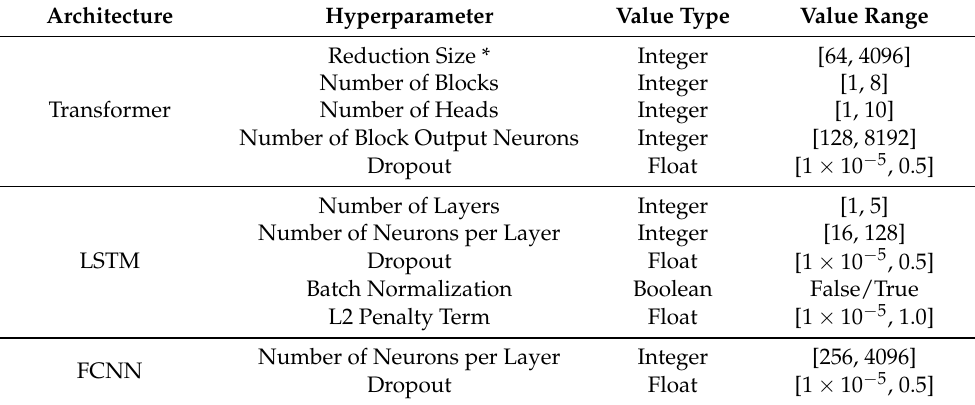
Table 2. Hyperparameter settings for the transformer, LSTM, and FCNN models. The table displays the architecture type in the first column, the hyperparameter name in the second column, the type of hyperparameter value in the third column, and the range of hyperparameter values in the fourth column. The FCNN model is represented as the regression component at the end of the transformer and LSTM models. (*) The reduction size hyperparameter is exclusive to the transformer architecture that focuses on all features